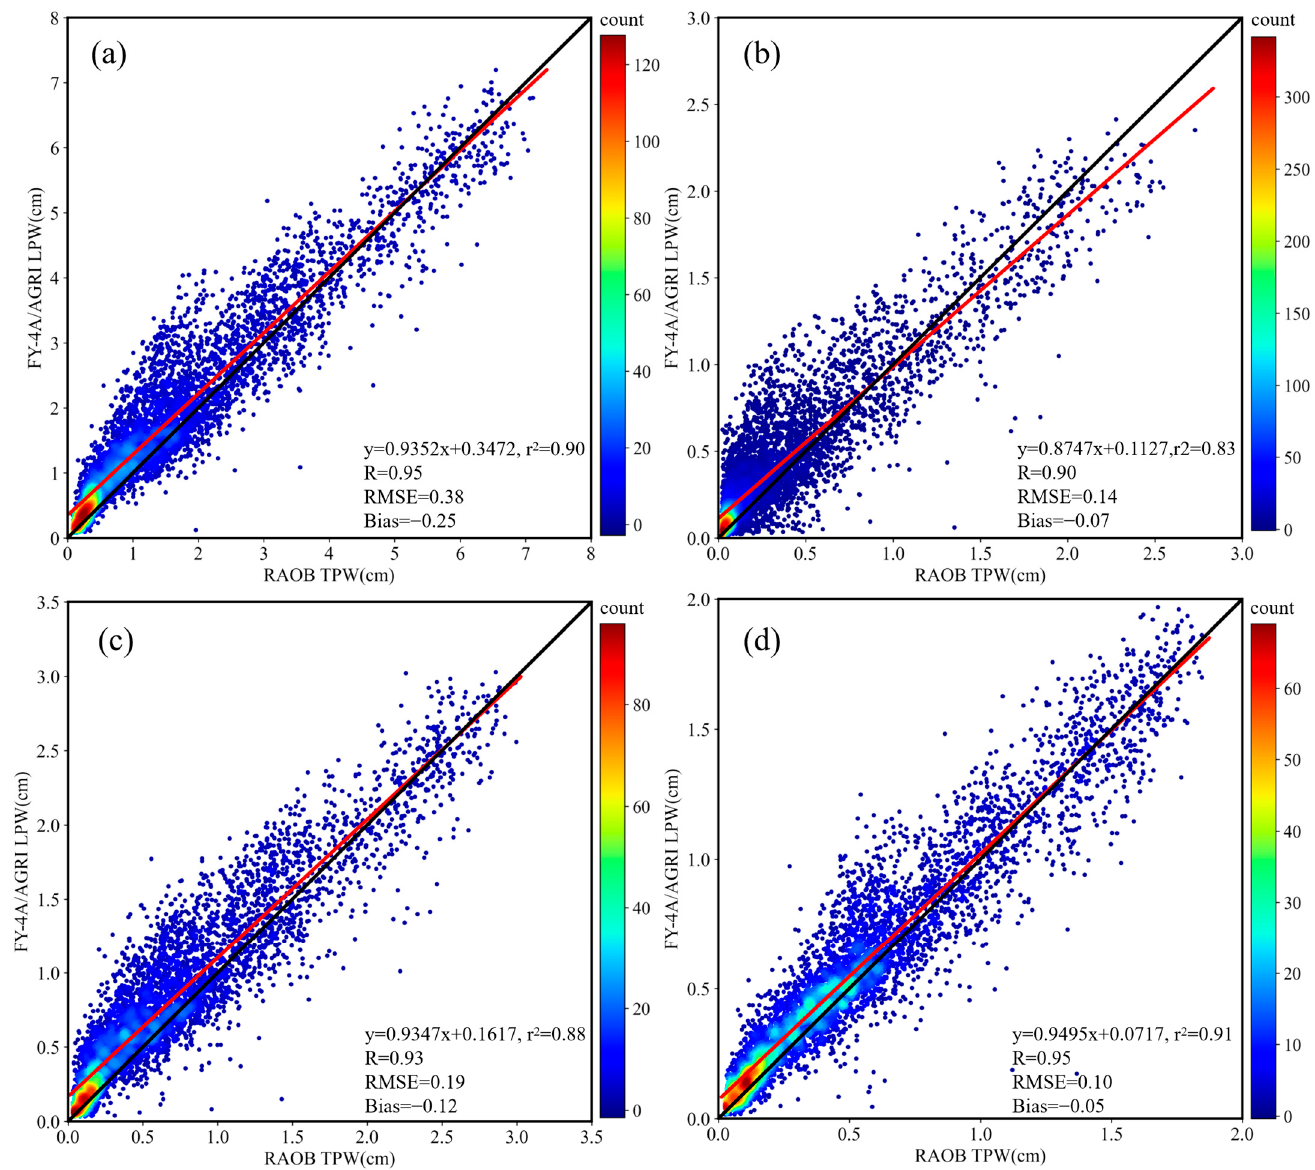
Figure 2. Scatter plot between FY-4A/AGRI LPW and RAOB TPW. ( a ) Whole layer; ( b ) high layer; ( c ) middle layer; ( d ) low layer.